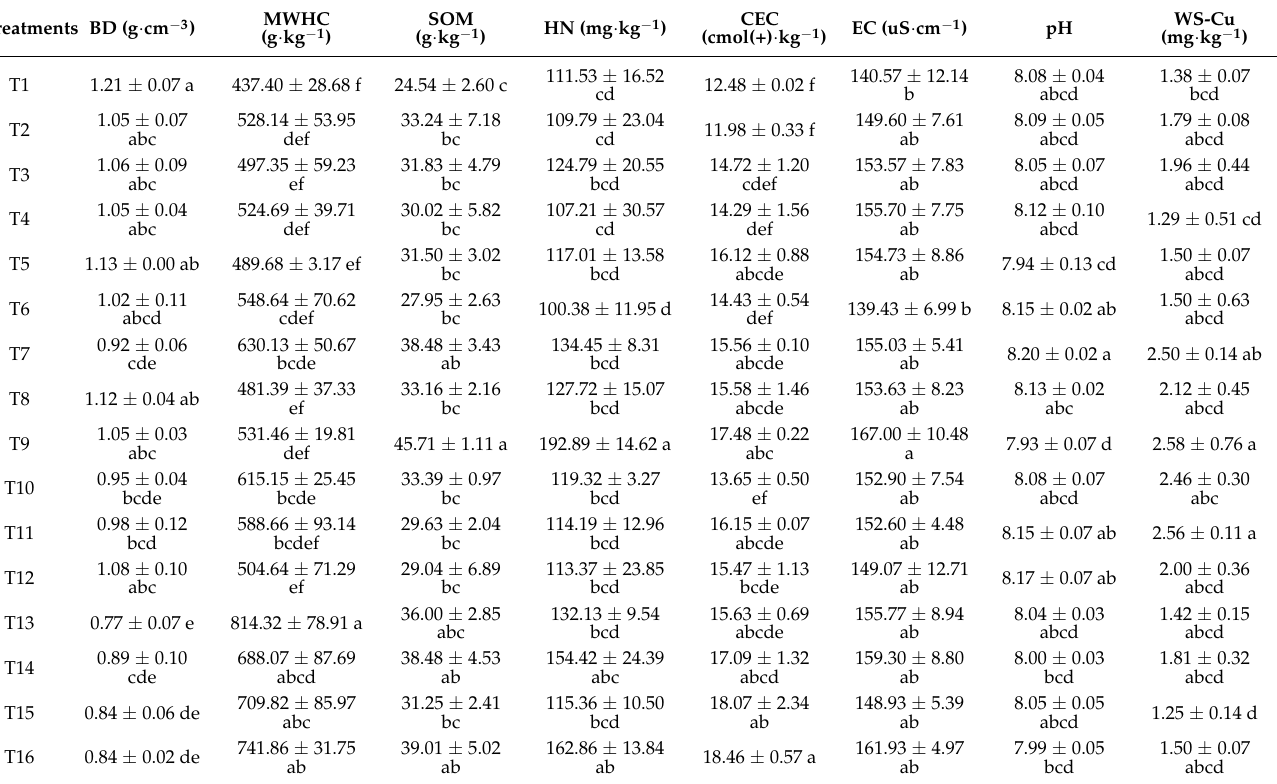
Table 3. Soil physiochemical characteristics in different